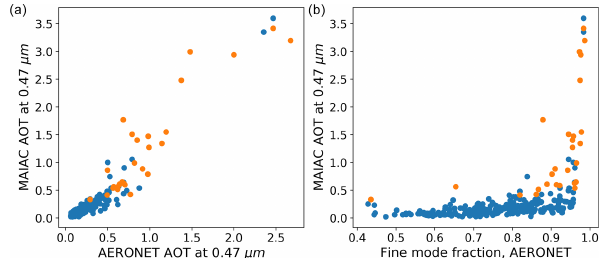
Figure 3. MAIAC AOT at 0.47µm against AERONET AOT (a) and MAIAC AOT at 0.47µm against fine-mode fraction AOT AERONET (b) according to the regional MAIAC aerosol model (blue colour) and in cases of smoke detection (orange colour). Moscow, 2001–2017.